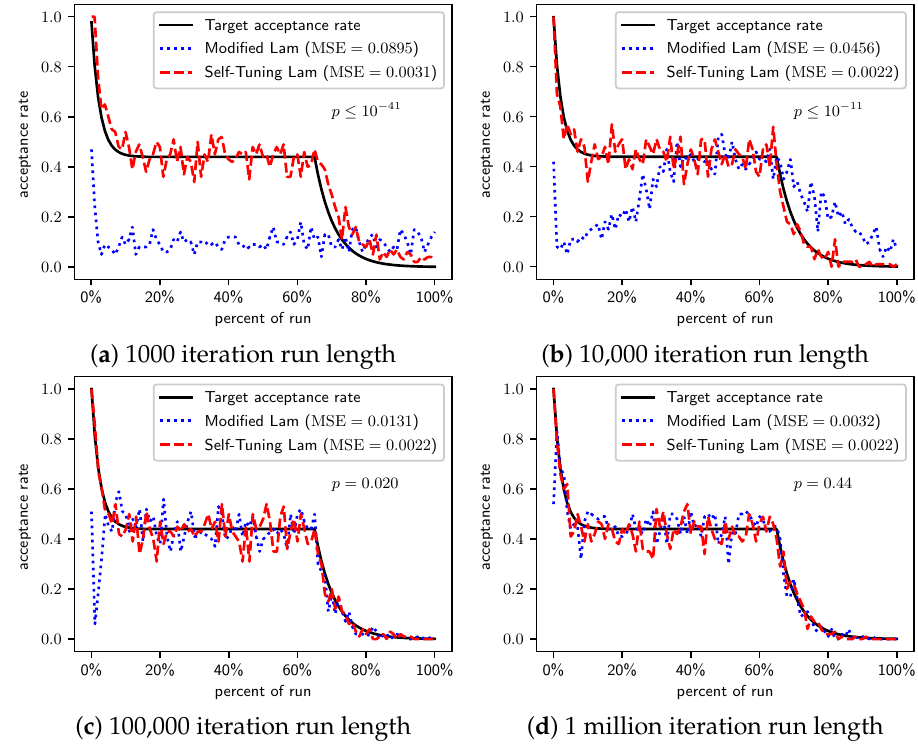
Figure 10. Minimize f 1,100 ( x ) : Self-Tuning Lam, Modified Lam, and target acceptance rates